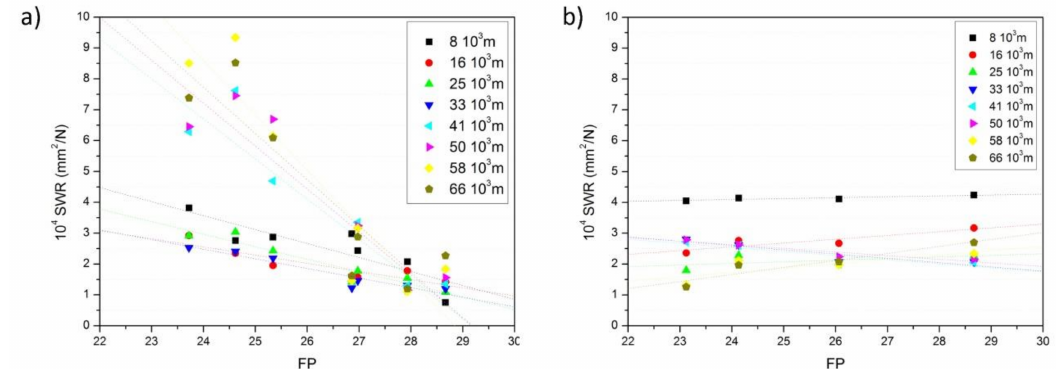
Figure 8. SWR and FP at the different braking distances ( a ) in the brake pads containing different concentrations of ELT and ( b ) in the brake pads containing ELT of different